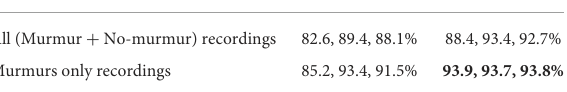
TABLE 6 Performance (sensitivity, specificity, accuracy) of the algorithm with five-fold cross-validation for the four Still’s murmur identification strategies.